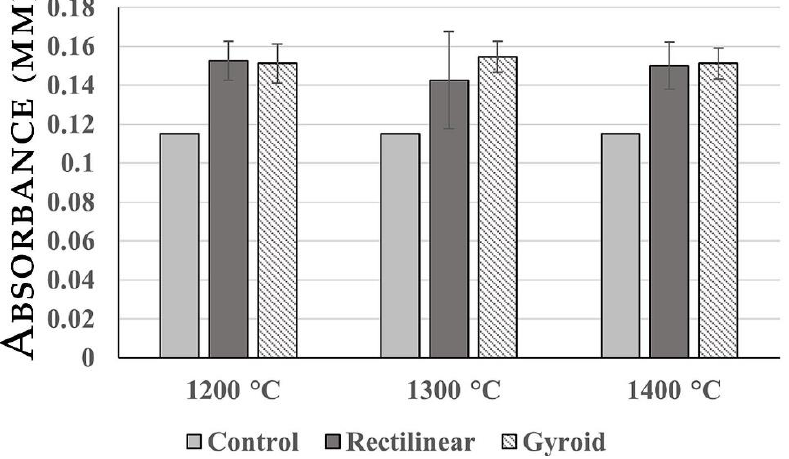
Figure 3. Results f the LDH release assay. LDH accumulation changes in the case of all analyzed scaffolds were insignificant, suggesting good biocompatibility.